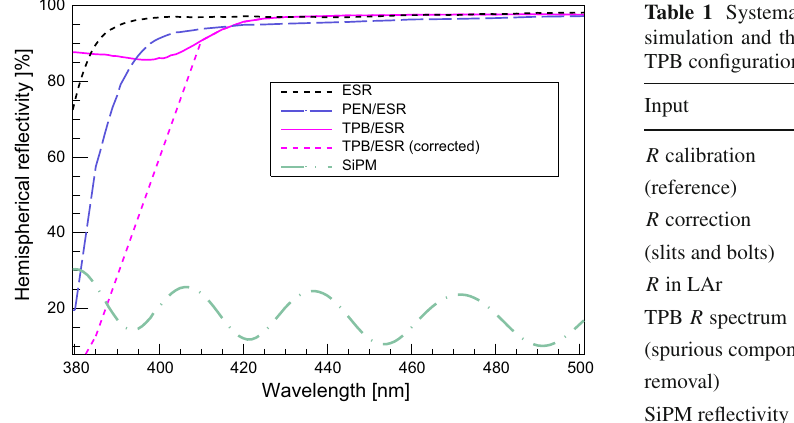
Fig. 7 Hemispherical reflectivity measured at 7 ◦ angle of incidence with a spectrophotometer equipped with an integrating sphere for: ESR, PEN air-coupled to ESR, TPB evaporated on ESR, TPB evaporated on ESR corrected for the spurious fluorescence component based on [2], and SiPMs (see legend)